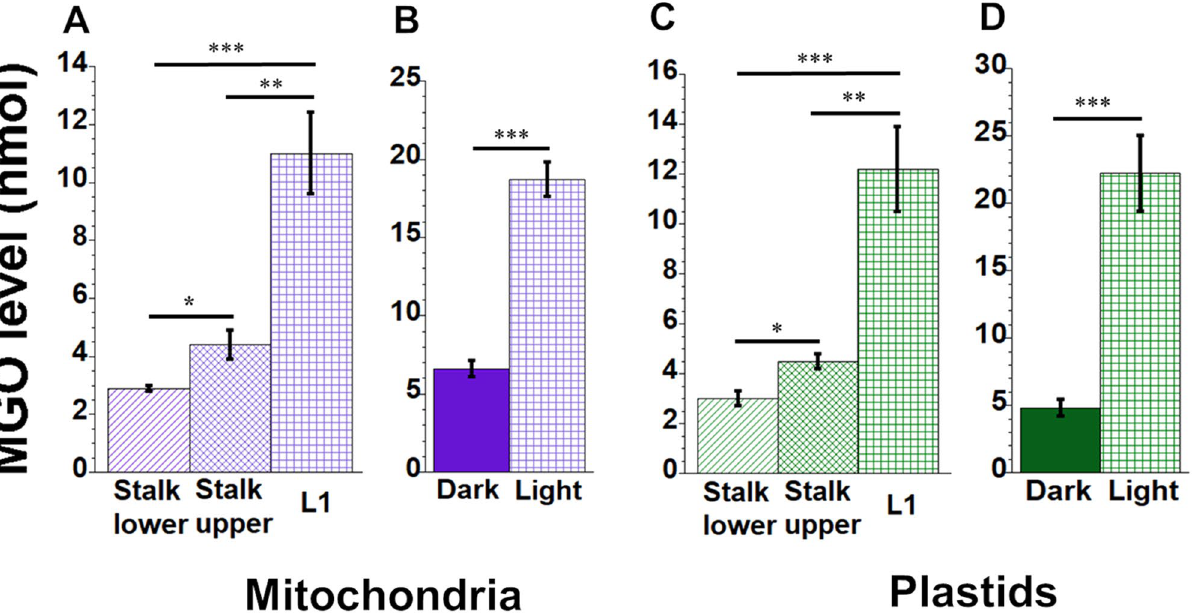
Figure 4. Methylglyoxal (MGO) in maize organelles. Mitochondria and plastids were isolated and MGO levels in nmole determined with a MGO assay kit as per manufacturer’s instructions. ( A and B ) show MGO in mitochondria; ( C and D ) show MGO in plastids.